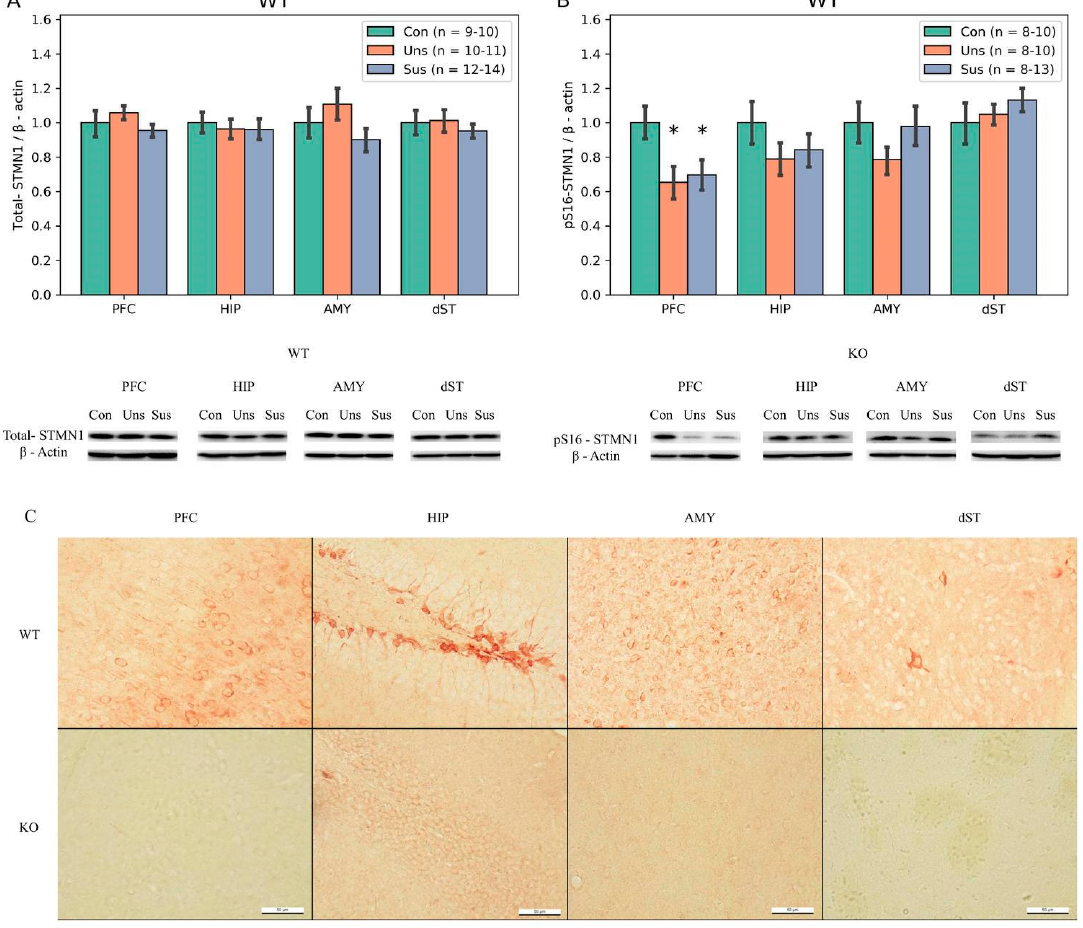
Figure 5. Western blot and immunohistochemistry (IHC) results of stathmin 1 ( STMN1 ) among three groups of STMN1 WT mice. ( A ) Total— STMN1 and ( B ) pS16— STMN1 . ( C ) Representative Immunohistochemistry staining images of anti-stathmin 1 (red) in the prefrontal cortex (PFC), dorsal hippocampus (HIP), amygdala (AMY) and dorsal striatum (dST) of WT control. No signal was detected in the KO control in all regions. Scale bar, 50 µ m. * p < 0.05 for main e ff ect of genotype; Con, Control; KO, Knock Out; Sus, Susceptible; Uns, Unsusceptible; WT,